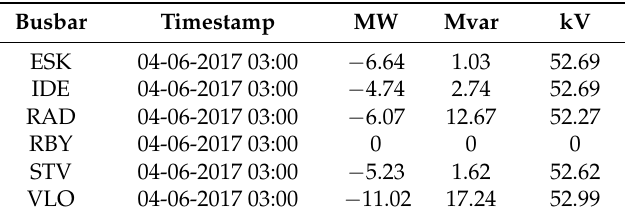
Table 1. Exchange of reactive power towards the transmission system operator (TSO), a high wind and low load scenario.